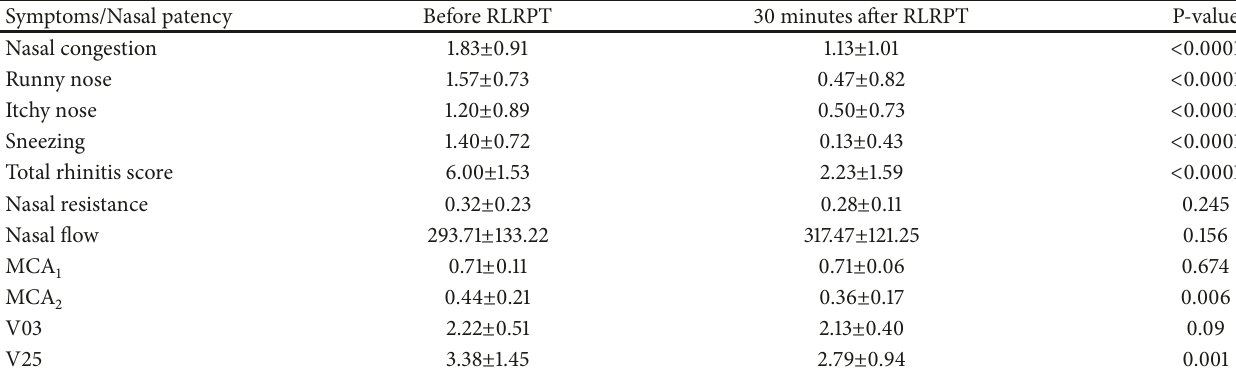
Table 1: Comparison before and 30 minutes after red light rhinophototherapy